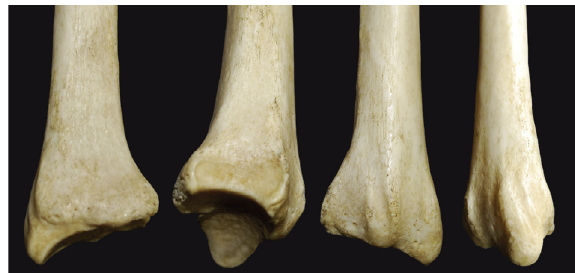
Figure 1. The four surfaces (anterior, medial, posterior, and lateral) of the distal radius are shown from left to right, along with the styloid process and dorsal